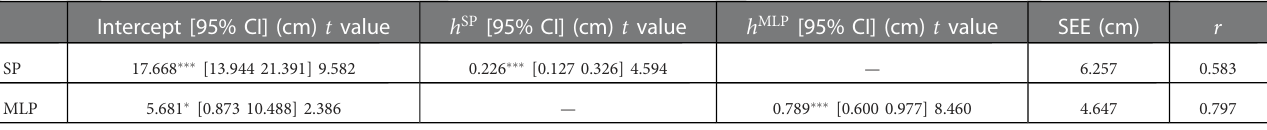
TABLE 6 Linear regression analysis performed between h FP with h SP and h MLP , respectively.